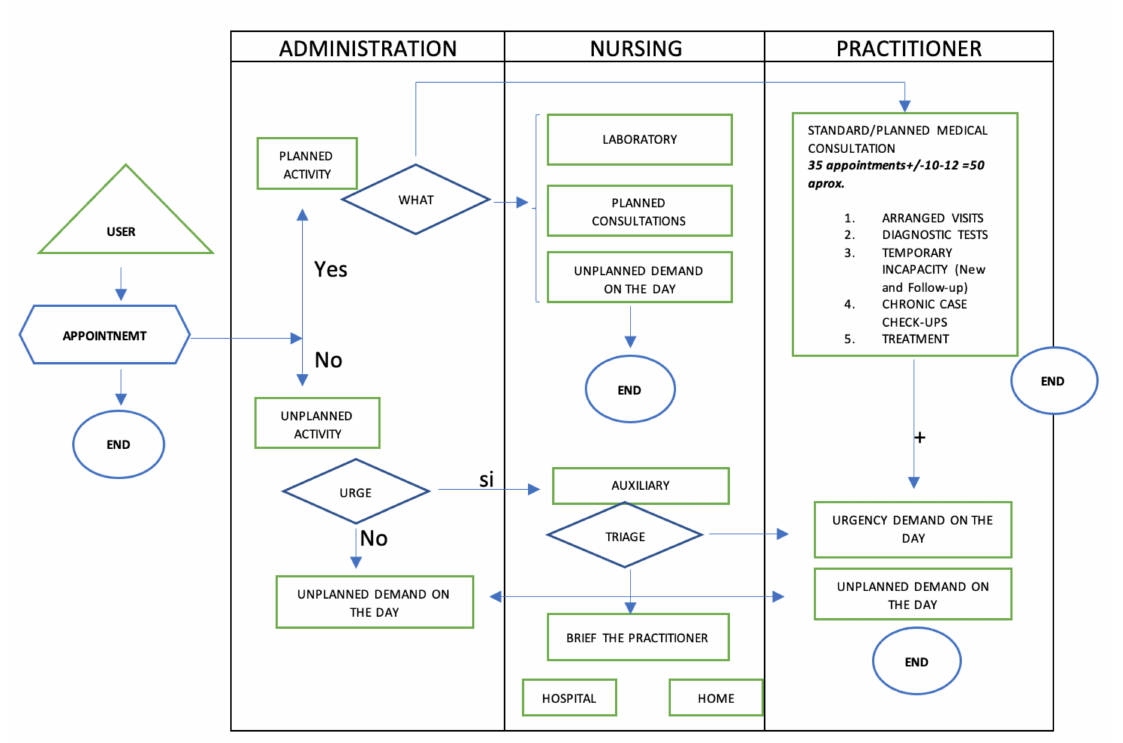
Figure 4. As-Is 2019 diagram of assistance